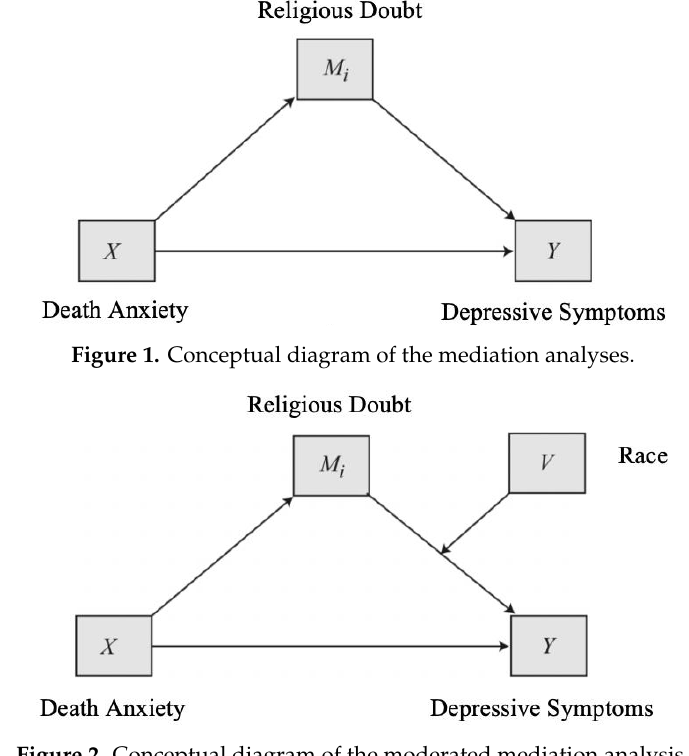
Figure 2. Conceptual diagram of the moderated mediation analysis.